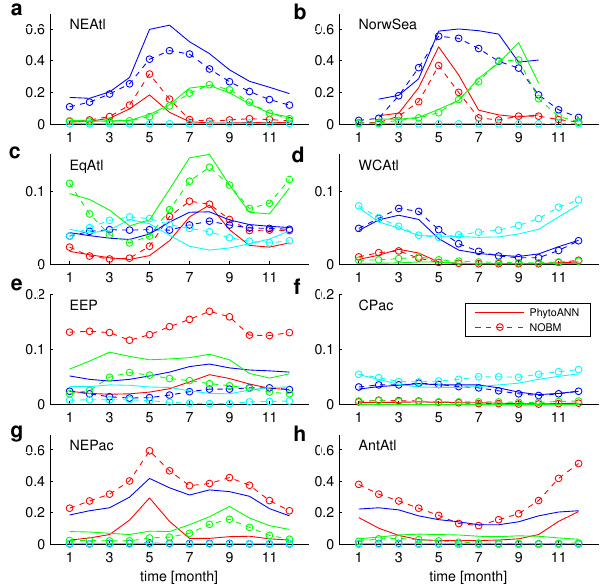
Fig. 7. 1997–2004 monthly climatology of NOBM (dashed lines with open circles) and PhytoANN (solid lines) phyto-PFT biomass estimates from confirmatory ( a NEAtl, b NorwSea, c EqAtl, d WCAtl) and exploratory areas ( e EEP, f CPac, g NEPac, h An- tAtl). Each plot includes four PFTs: diatoms (red), coccolithophores (blue), chlorophytes (green) and cyanobacteria (cyan). All phyto- PFT biomass in units of mgChlm − 3